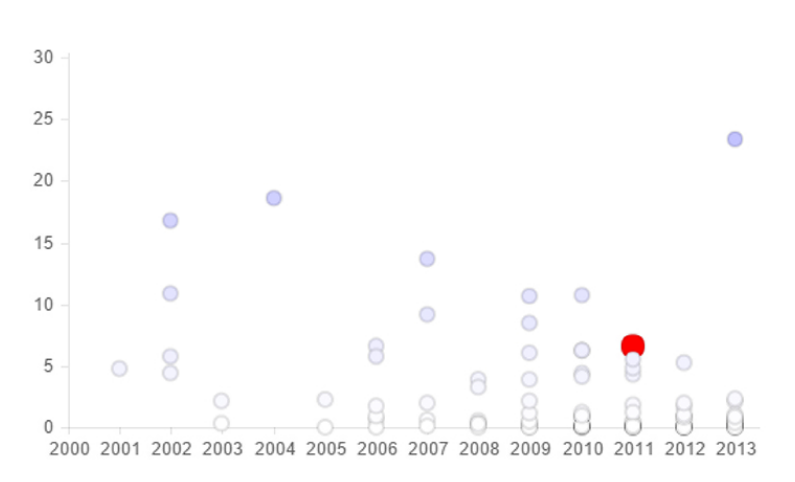
Figure 13. Scatter plot shows the place of paper among